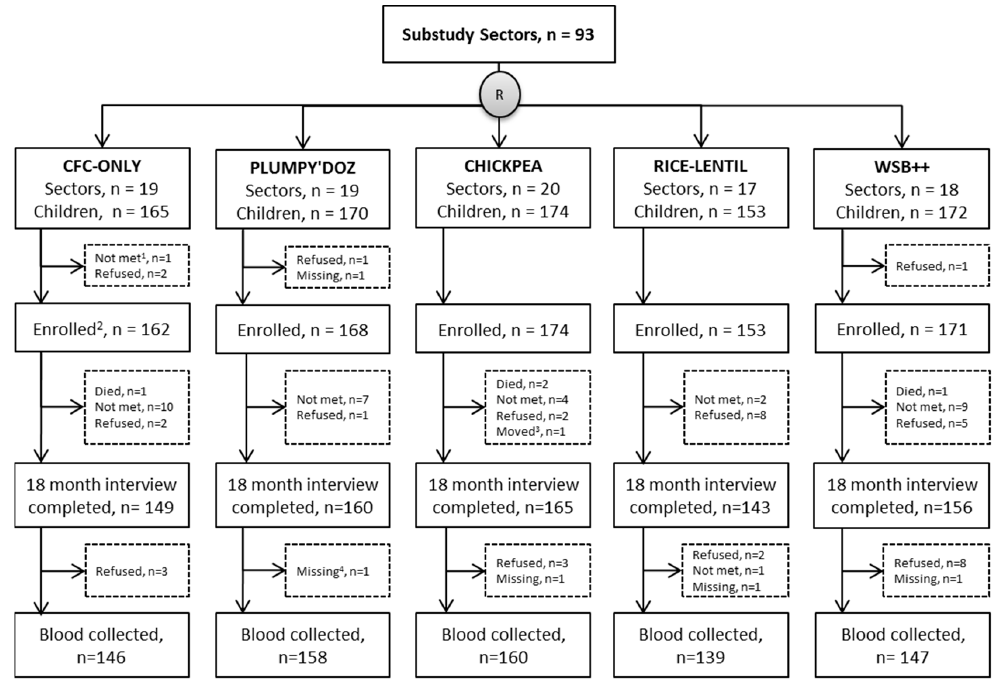
Figure 1. Flow diagram of participants with serum collected at 18 months of age for micronutrient status assessment in a complementary food supplementation trial in Bangladesh